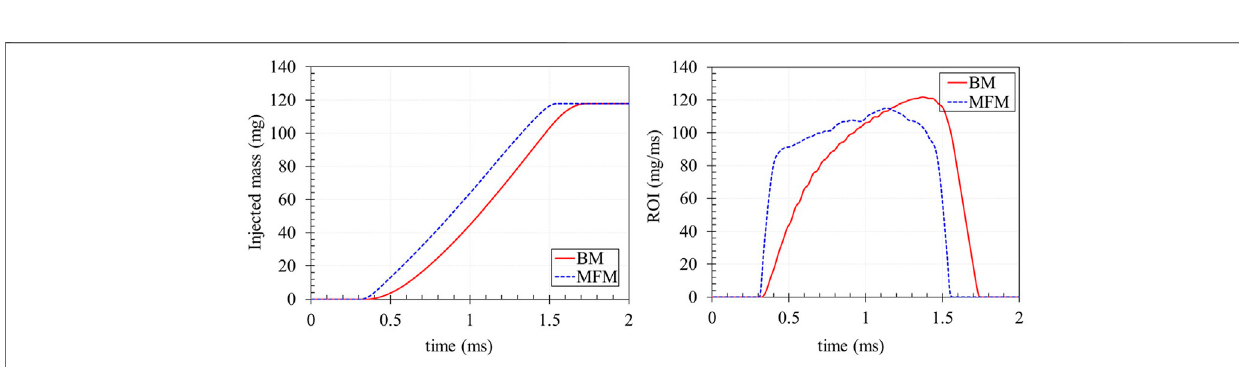
Frontiers in Mechanical Engineering |